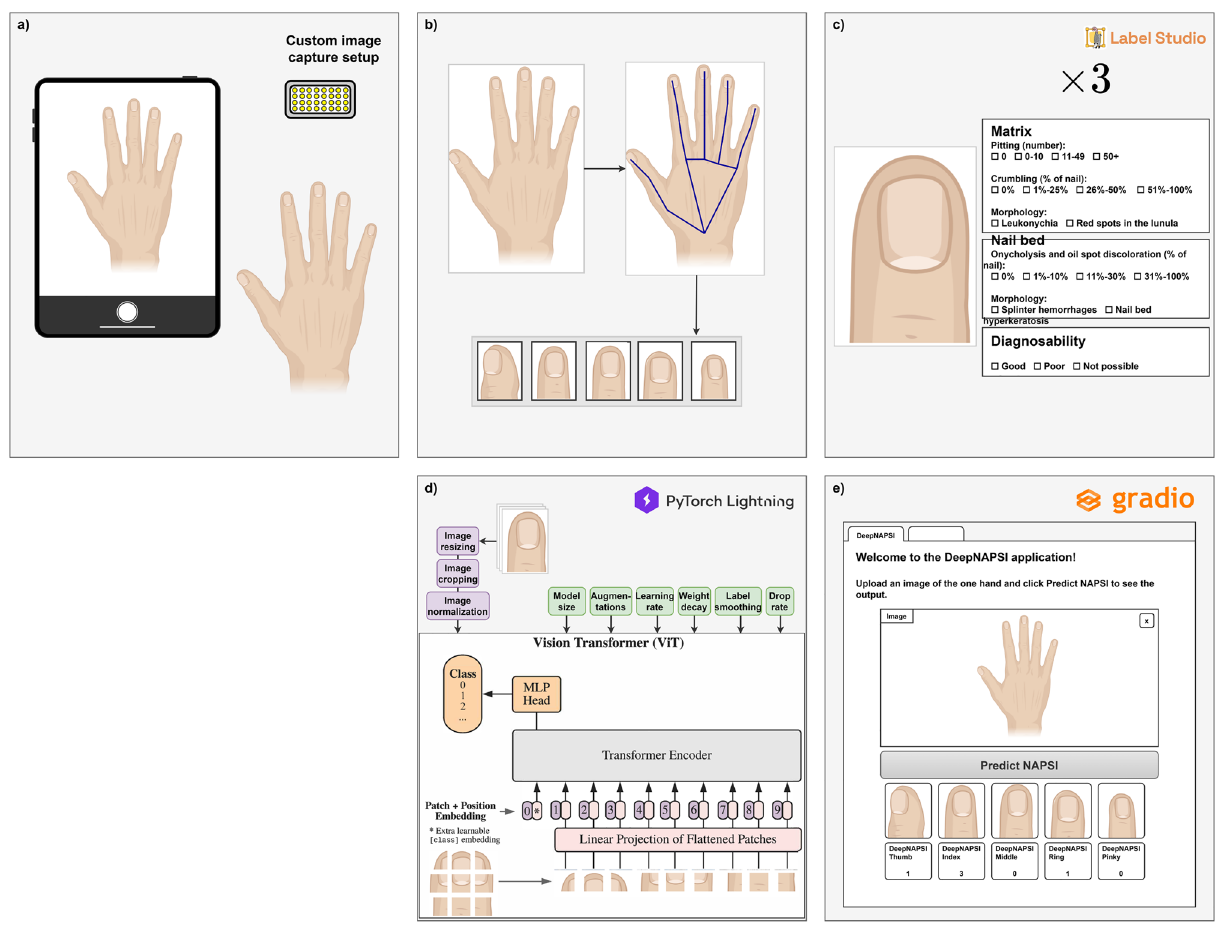
Figure 1. Overview of the proposed method. ( a ) The first step is the recording and storing of hand photos of patients using a custom setup and a purpose-built mobile application. ( b ) Based on key points extracted from the hand images using mediapipe, the location of each nail can be determined. ( c ) Each nail is graded by three independent readers according to the modified nail psoriasis severity index (mNAPSI). ( d ) A neural network (BEiT) is trained to classify the mNAPSI score of the presented nail. ( e ) Open-access to the trained system is provided upon request resulting in the network-predicted mNAPSI score for each